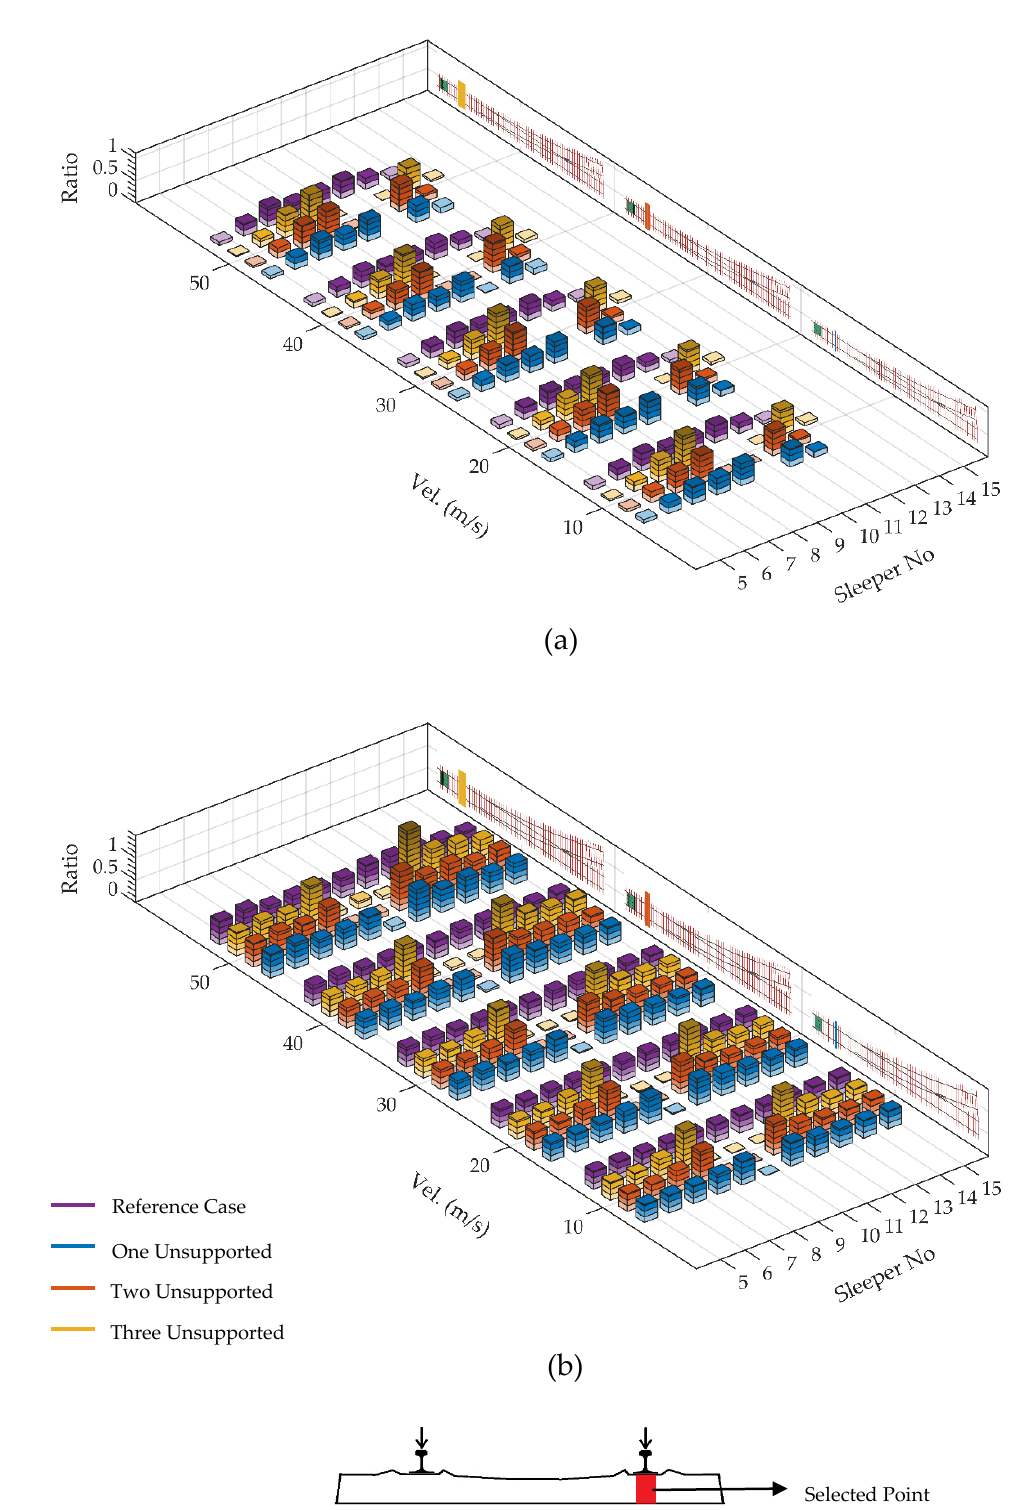
Figure 10. The distribution of rail seat force over the bearers when unsupported bearers exist at normal track section: ( a ) at particular time when the front wheel is on the bearer with number 10; ( b ) when maximum occurs at each bearer.